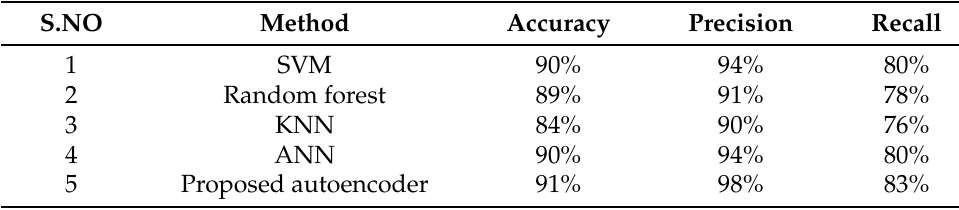
Table 1. Comparison results with other state-of-the-art